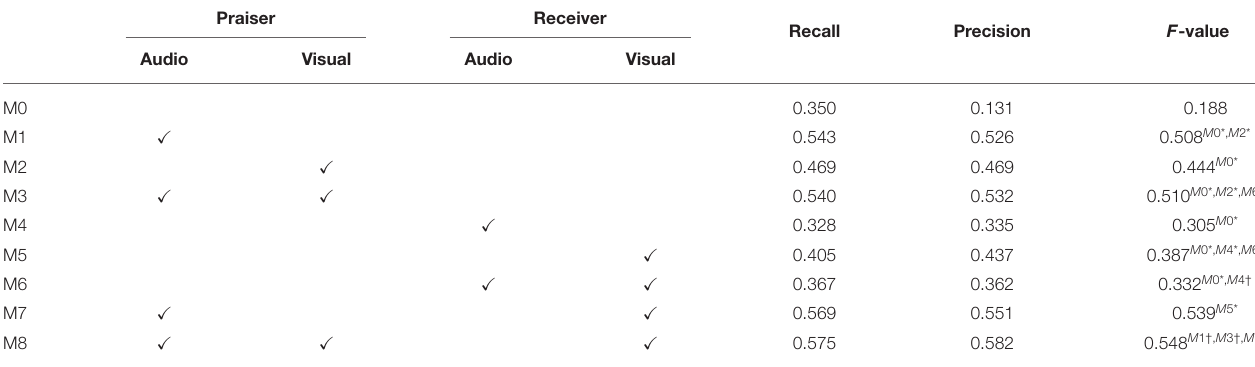
TABLE 2 | Evaluation results for the proposed models. Praiser Receiver